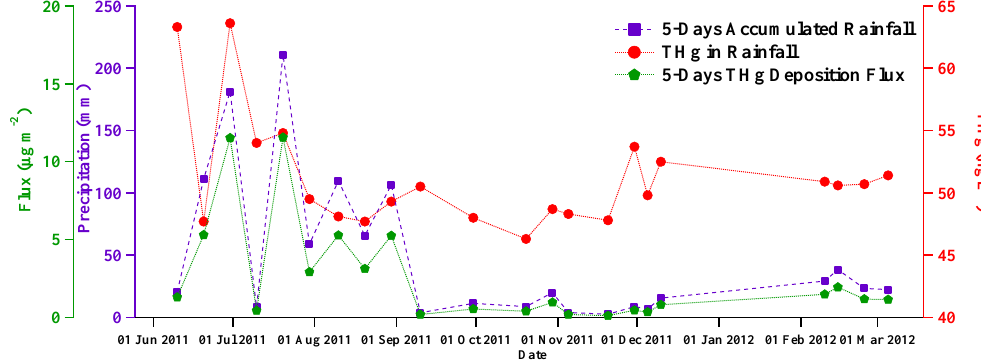
Fig. 1. Time series of mercury concentration in precipitation, wet deposition flux, and precipitation. Table 1. The statistical summary of mercury concentration, precipitation, and wet deposition flux. VWM